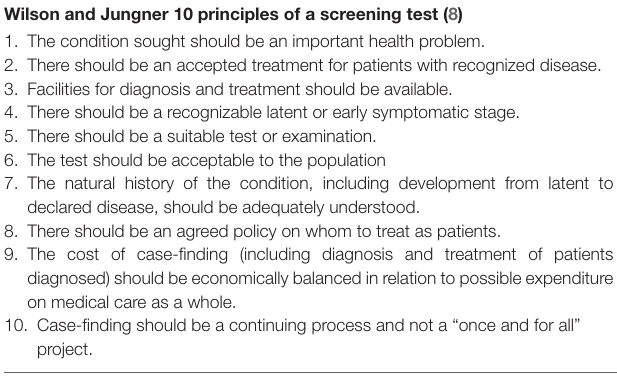
TABLE 1 | Wilson and Jungner principles and 2006 ACMG criteria. Wilson and Jungner 10 principles of a screening test